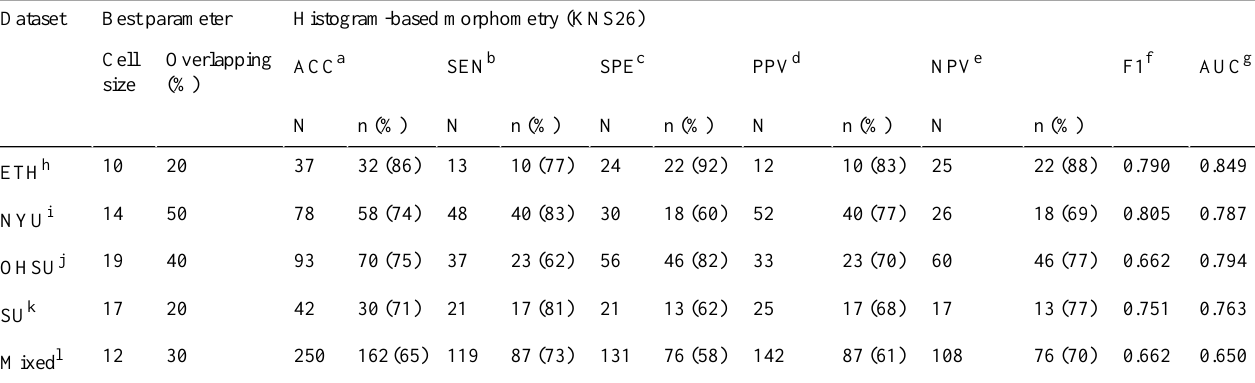
Table 3. Classification performance using histogram-based morphometry on the second edition of the Autism Brain Imaging Data Exchange datasets. Histogram-based morphometry (KNS26)Best parameterDataset